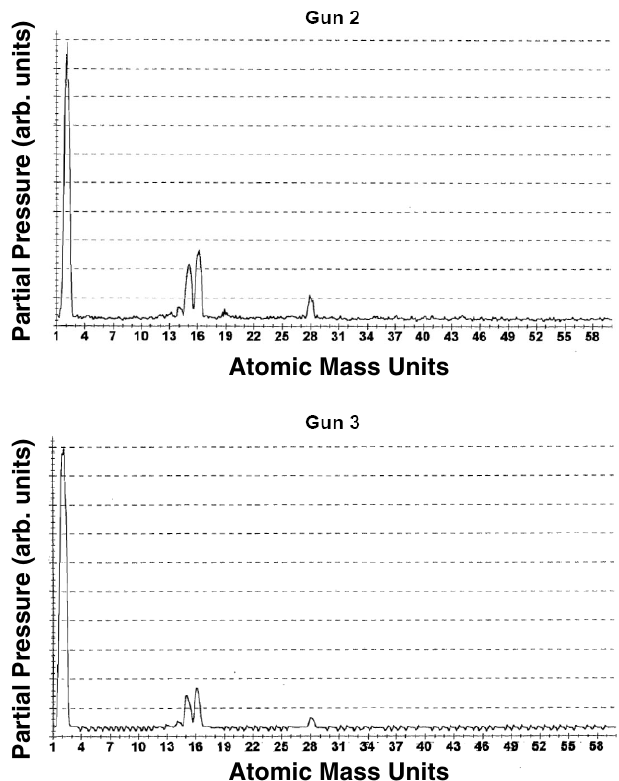
FIG. 11. Residual gas spectra for the nominally identical pho- toguns of the third polarized source. The spectra are virtually identical with hydrogen the dominant gas species. Trace amounts of methane (masses 12 through 16) and carbon mon- oxide are observed. The mass 19 peak is a result of electron stimulated desorption associated with our use of NF activation. The labels Gun2 and Gun3 are historical designa- tions, with Gun1 corresponding to the original CEBAF therm- ionic gun, now